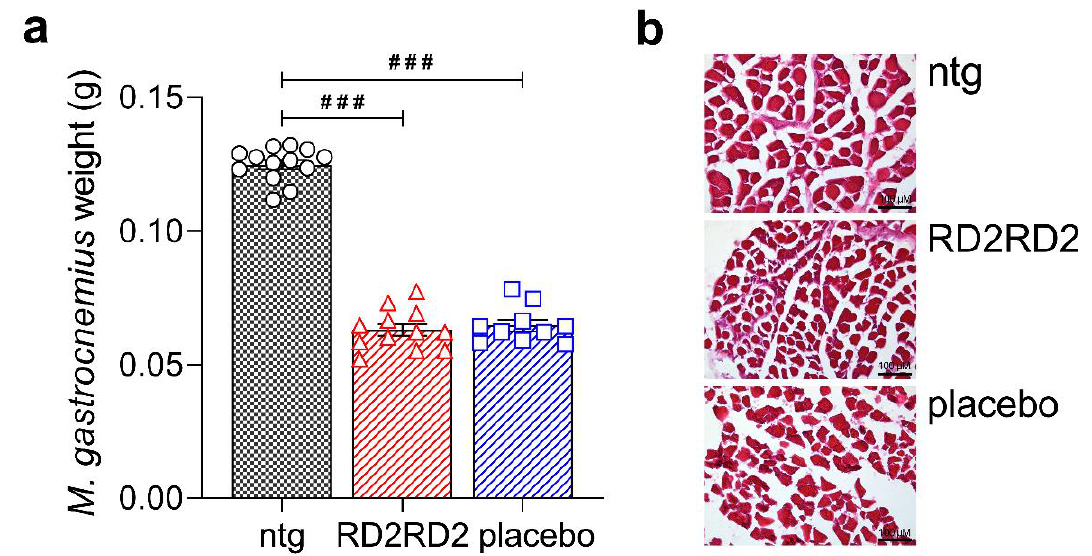
Figure 5. Analysis of the M. gastrocnemius in SOD1*G93A mice. Weighing of the M. gastrocnemius of both hind limbs revealed a significant difference between non-transgenic and transgenic mice, but not between treatment groups ( a ). A first staining of muscle slices was conducted with haematoxylin and eosin (H&E) to assess muscle degeneration ( b ). Data is presented as mean ± SEM. Statistical calculations were conducted by one-way ANOVA with Fisher’s LSD post hoc analysis, ntg n = 13, RD2RD2 n = 12 and placebo n = 10. Lozenges ( # ) indicate a significance between treatment groups (ntg vs. RD2RD2 or ntg vs. placebo: ### p < 0.001). Circles: placebo-treated ntg; triangles: RD2RD2-treated SOD1*G93A mice and squares: placebo-treated SOD1*G93A mice.